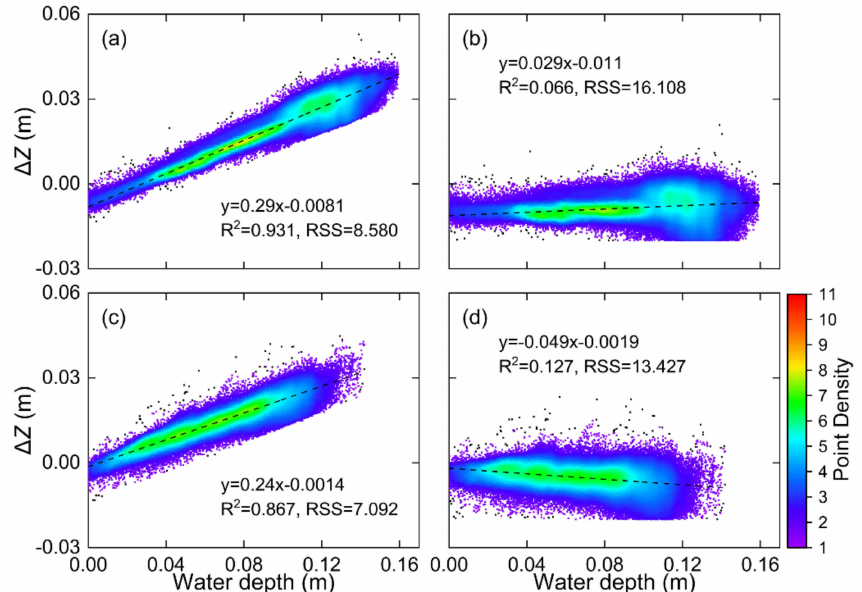
Figure 11. Relations between water depth and elevation differences for the combined results: ( a ) un- corrected models for MR1; ( b ) corrected models for MR1; ( c ) uncorrected models for MR2; and ( d ) corrected models for MR2. All the through-water SfM models used the bank GCP layout, and the points with elevation errors < − 0.02 m in the corrected models were removed. The linear regression for each relation is presented with the regression equation, R-square, and residual sum of squares